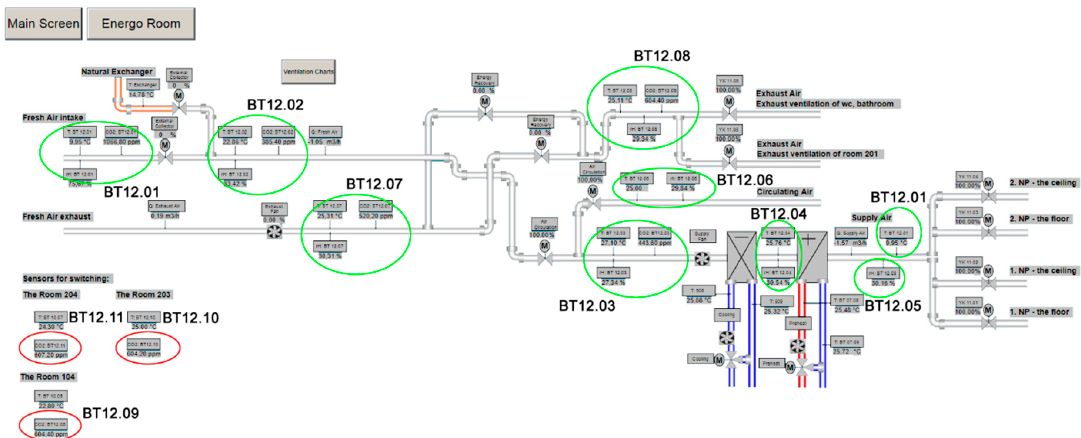
Figure 7. The ventilation distribution technology with the location of the individual sensors for CO 2 measurement in an SH.